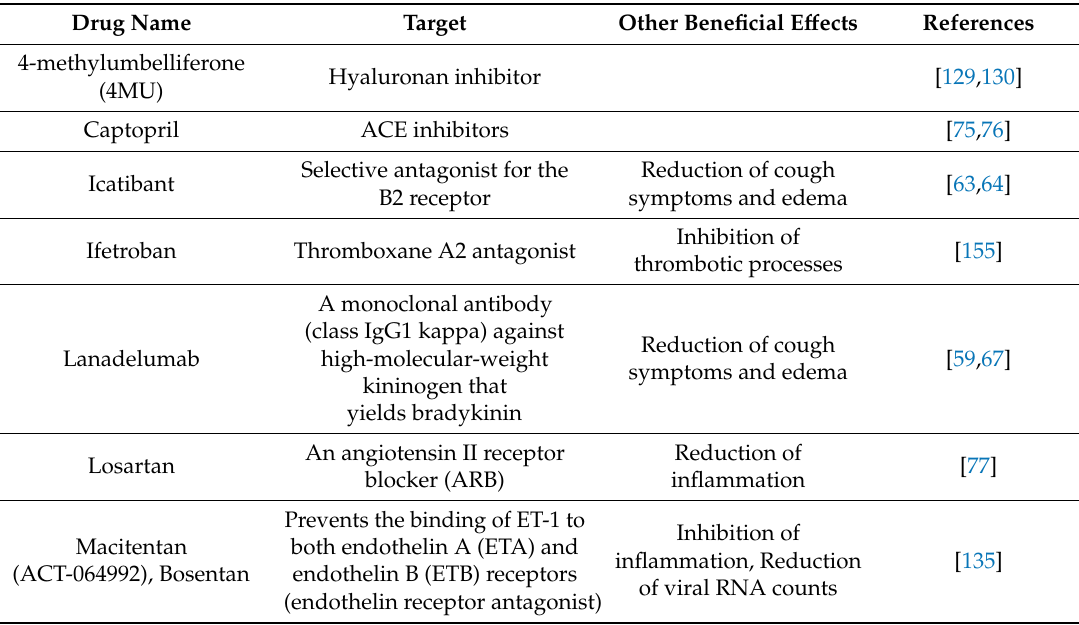
Table 2. Clinically tested drugs that a ff ect pulmonary vasoconstriction that could be used in